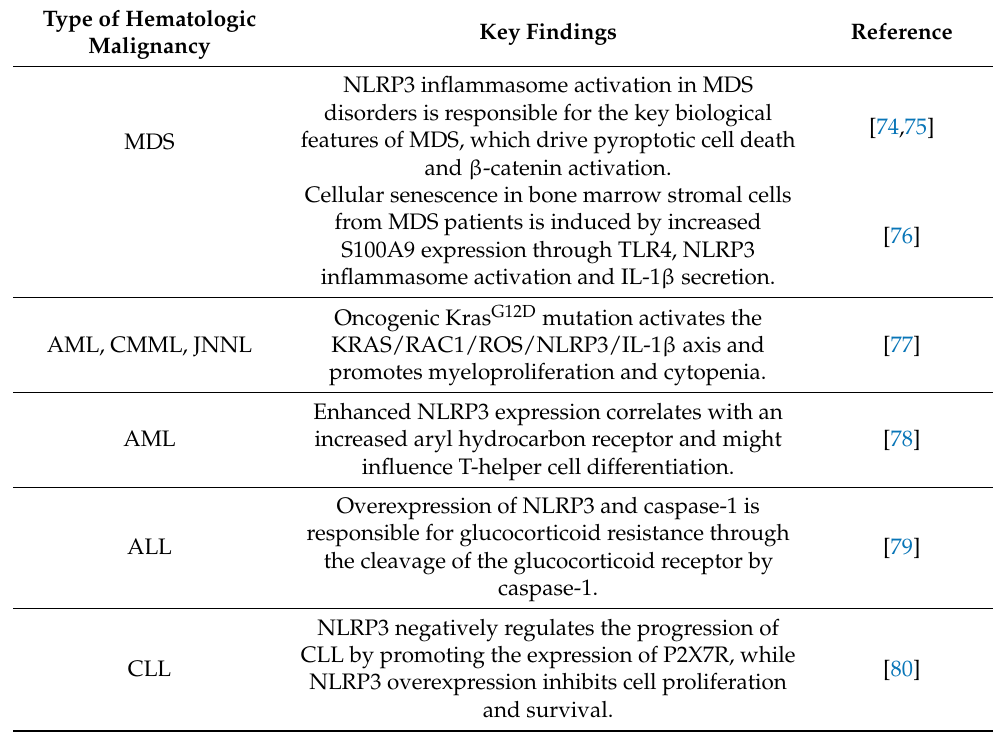
Table 1. Key findings of the role of the NLRP3 inflammasome in different hematologic malignancies. NLRP3, NOD-like receptor protein 3; MDS, myelodysplastic syndrome; IL-1 β , interleukin-1 β ; TLR4, Toll-like receptor 4; KRAS, Kristen rat sarcoma viral oncogene homolog; RAC1, Ras-related C3 botulinum toxin substrate 1; ROS, reactive oxygen species; AML, acute myeloid leukemia;